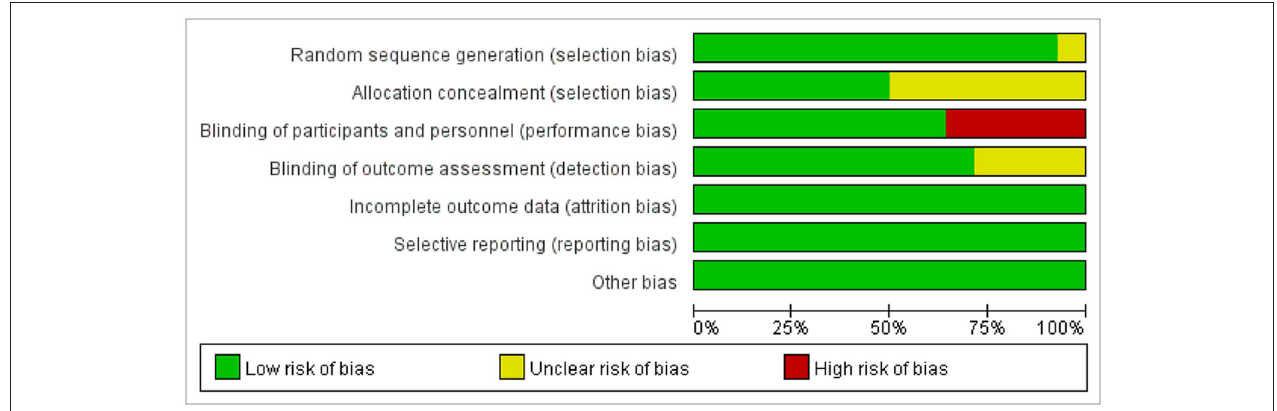
FIGURE 2 | Performance of each type of bias in all